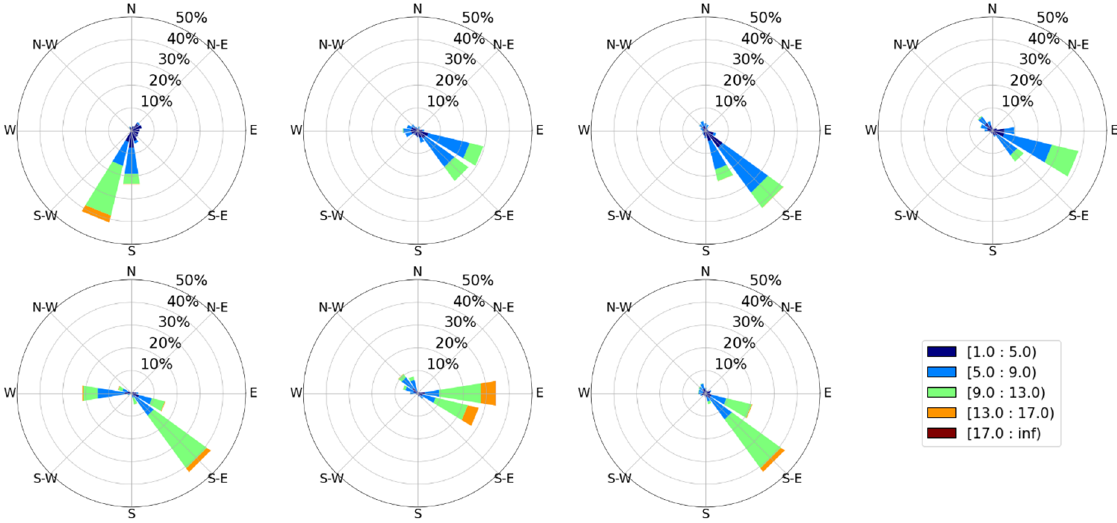
Figure 3. Wind roses in 2015 for the onshore Banyuwangi, Baron, Lebak, and Sukabumi sites ( top , left to right) and offshore Wetar, Jeneponto, and Banten sites ( bottom , left to right).